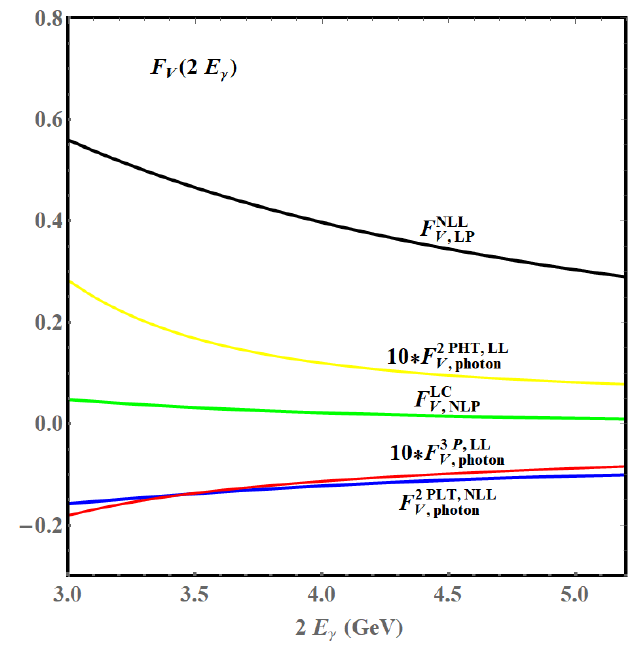
Figure 5 . The photon-energy dependence of di(cid:11)erent terms contributing to the vector B ! (cid:13) form factor F V (2 E (cid:13) ) as displayed in (4.15) with the central values of theory inputs. The individual contributions correspond to the leading-power contribution at NLL computed from the QCD factor- ization approach ( F NLL , black), the subleading-power local contribution at LO ( F LC V; LP two-particle leading-twist hadronic photon correction at NLL ( F 2PLT ; NLL higher-twist hadronic photon correction at leading-logarithmic (LL) accuracy ( F 2PHT ; LL the three-particle leading-twist hadronic photon correction at LL ( F 3P ; LL